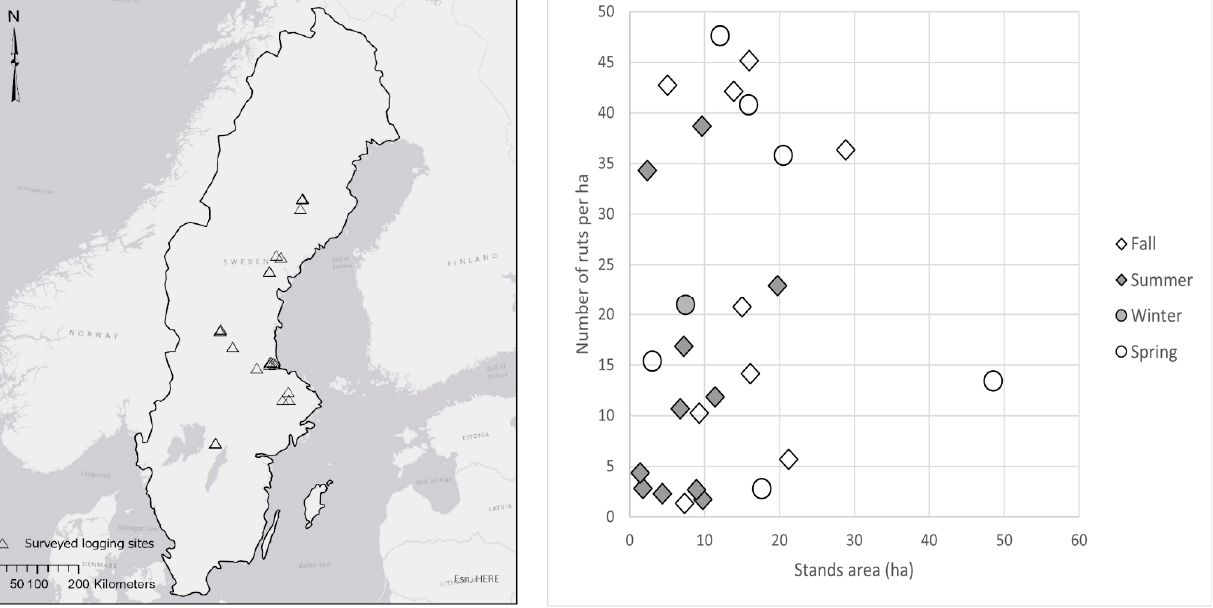
Figure 1. ( Left ) Surveyed logging sites in Sweden. ( Right ) Distribution of ruts per hectare logging site area with the season of logging site operations indicated. Ruts were defined as machine tracks with a minimum depth of 10 cm and a minimum length of 1 m. Table 1. Summary of input data used in this study: field-surveyed, spatial, and S-HYPE-data.